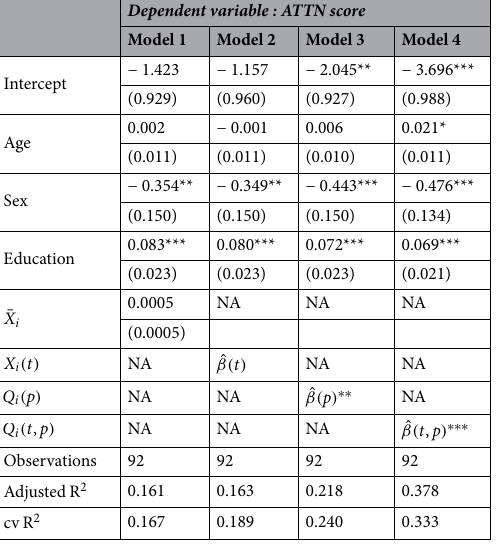
Table 3. The results of modelling attention score and physical activity using Model 1–4 with an adjustment for age, sex, and education. The standard deviation of the estimated coefficients for the scalar predictors are indicated in the parenthesis. Predictors: model 1-scalar average PA, model 2-diurnal PA curves, model 3-quantile functions, model 4-SOTDR with time-by-distribution data objects. All models are adjusted for age, sex, years of education. * p < 0.1 ; ** p < 0.05 ; *** p < 0.01